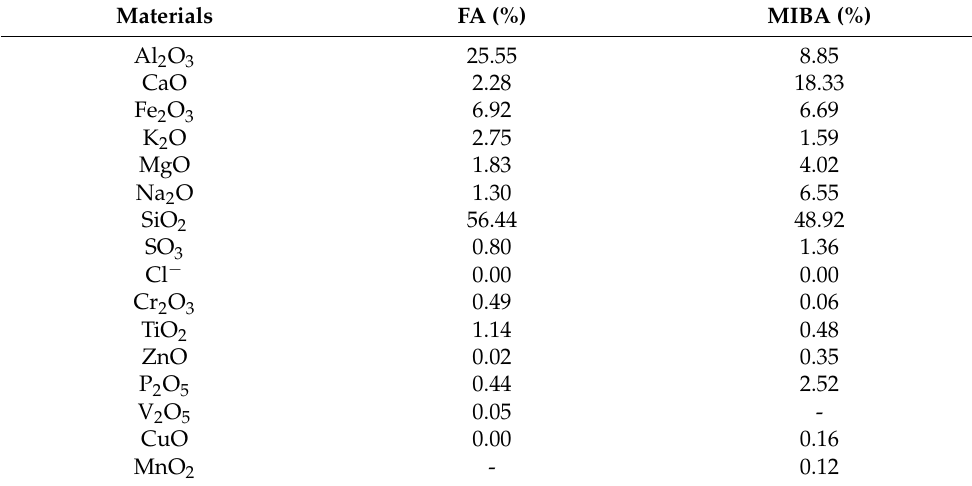
Table 3. Chemical composition of raw materials, FA, and MIBA (% by